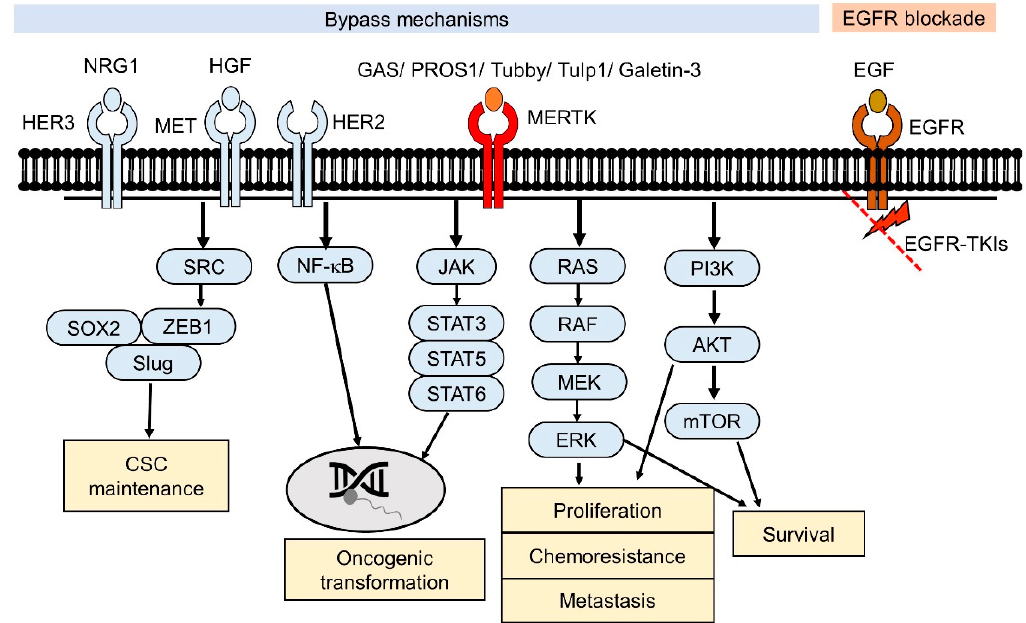
Figure 1. Effects of the Mer receptor tyrosine kinase (MERTK)-mediated signaling pathway in epidermal growth factor tyrosine kinase inhibitors (EGFR-TKI) resistance. For EGFR-TKI resistance without the acquired T790M mutation in EGFR, the downstream signaling pathways of EGFR are still blocked by EGFR-TKIs. Alternative RTK-mediated signaling pathways (bypass) contribute to the survival of the EGFR-TKI-resistant cancer cells. Through binding to their ligands, MERTK-induced signaling pathways may crosstalk with other RTK-mediated signaling pathways that promote cell survival.